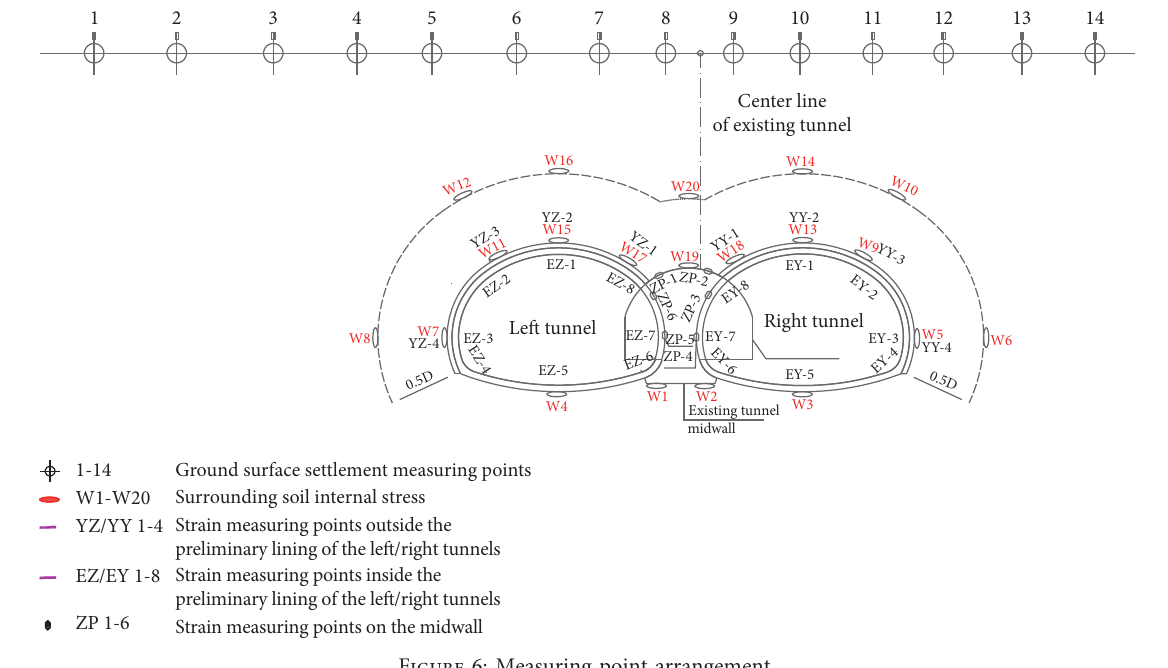
Figure 6: Measuring point arrangement.